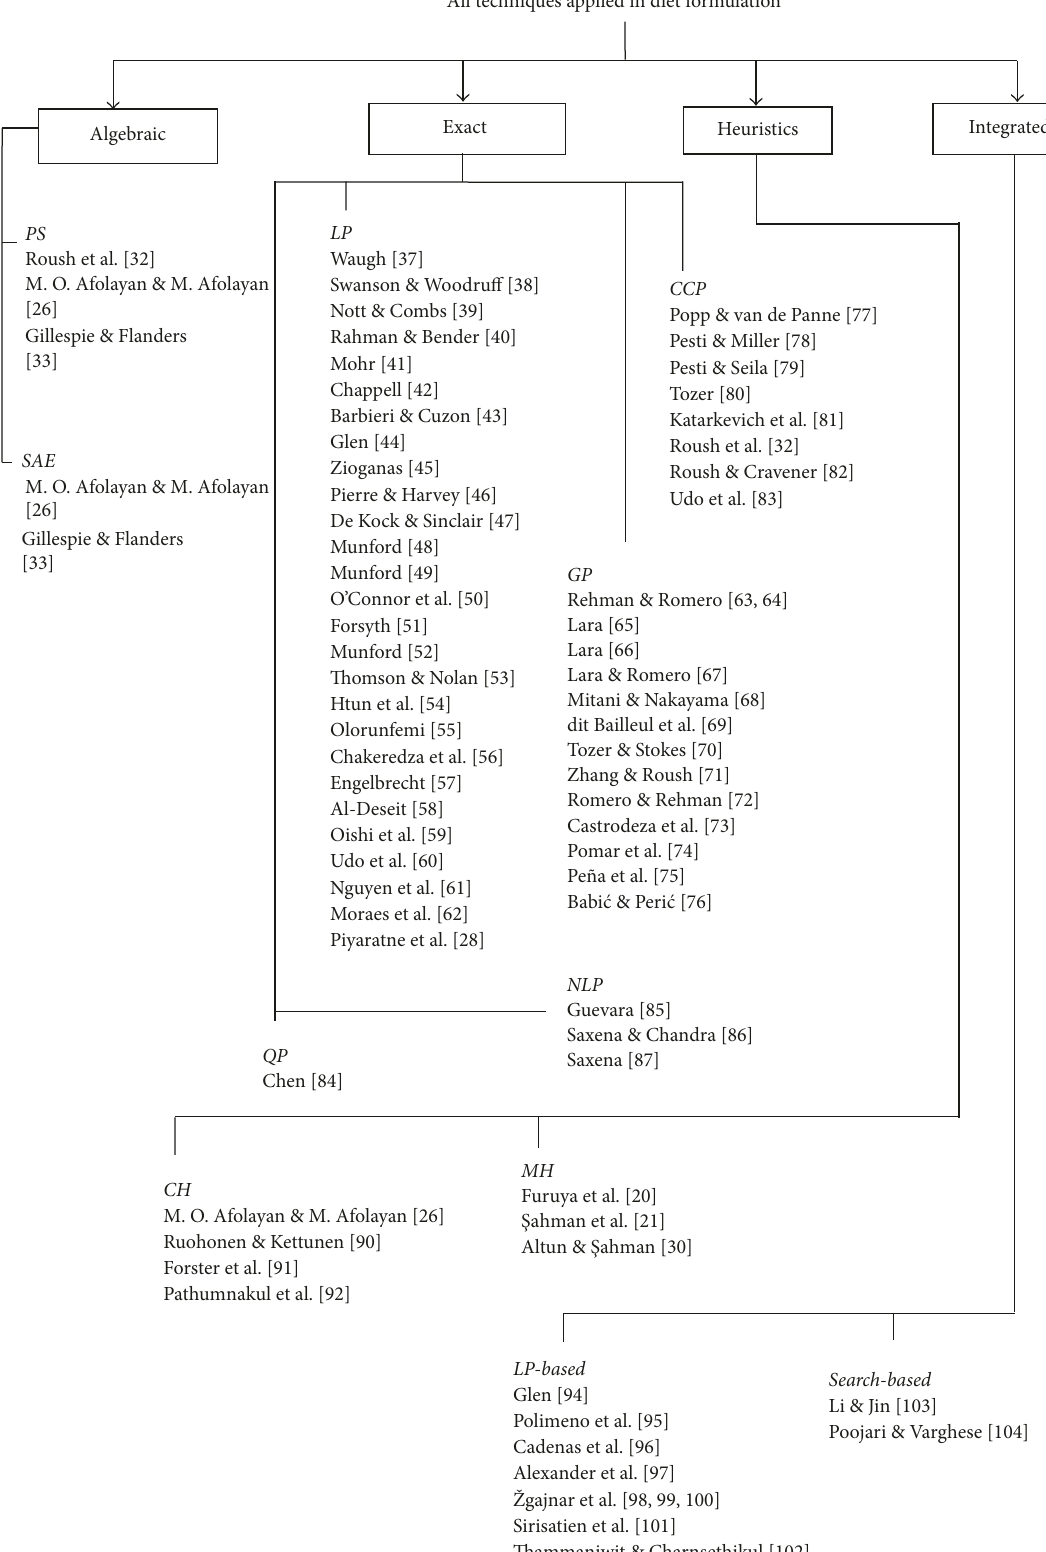
Figure 1: Classification of solution techniques for feed formulation problems as adapted and enhanced from Rahman